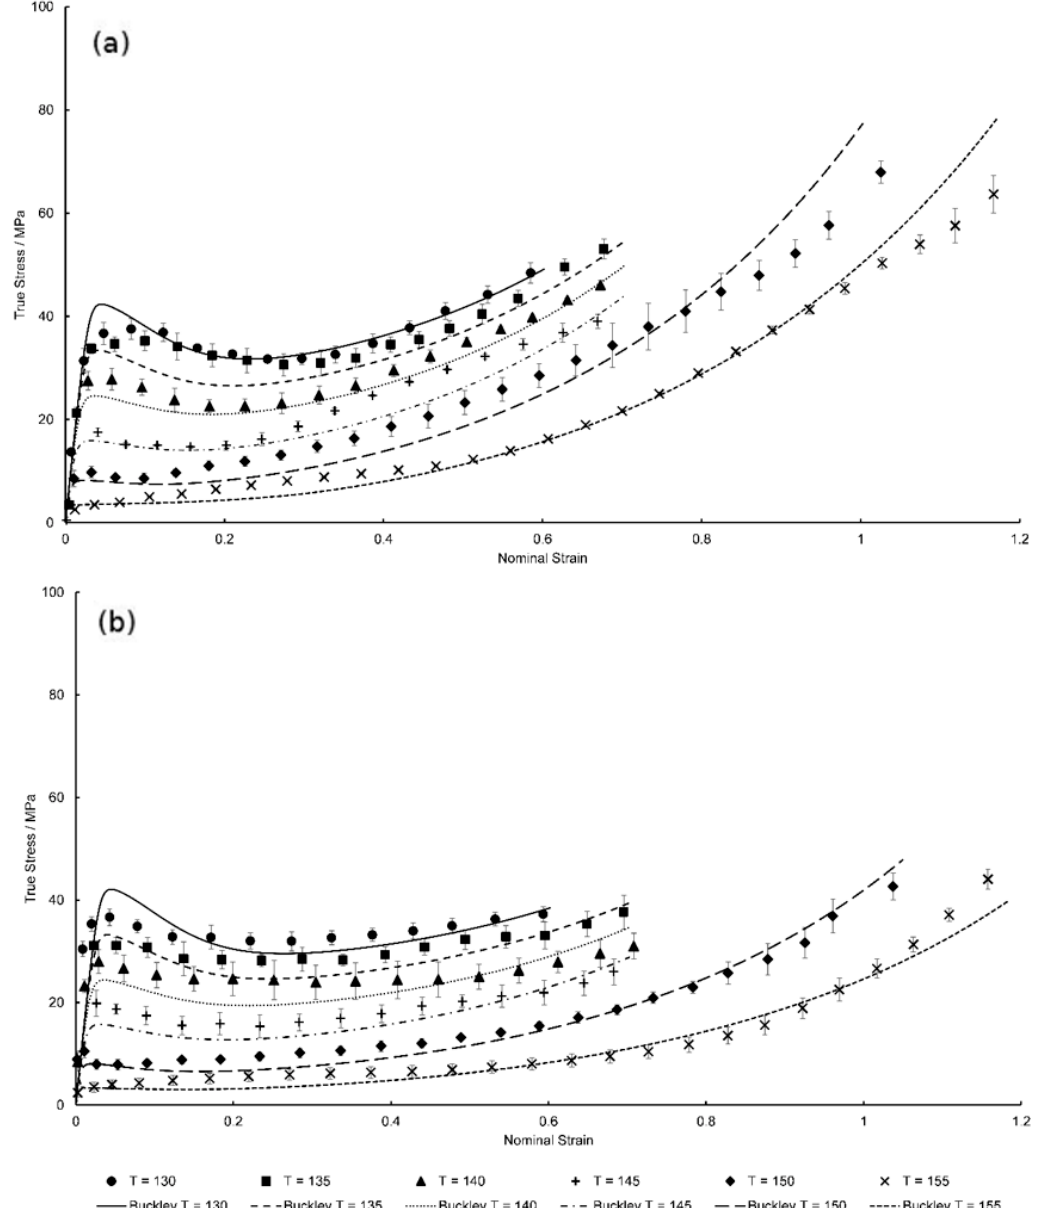
Figure 19. Predicted EB deformation behaviour by modified Buckley model for temperatures between 130 and 155 °C in the ( a ) machine direction and ( b ) transverse direction.